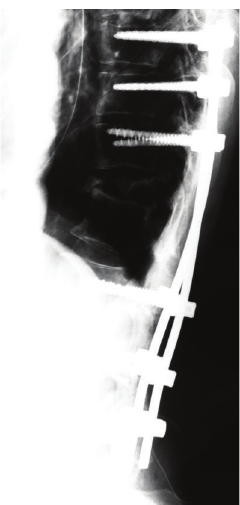
Figure 3: Lateral view on plain X-ray radiography after the first surgery.